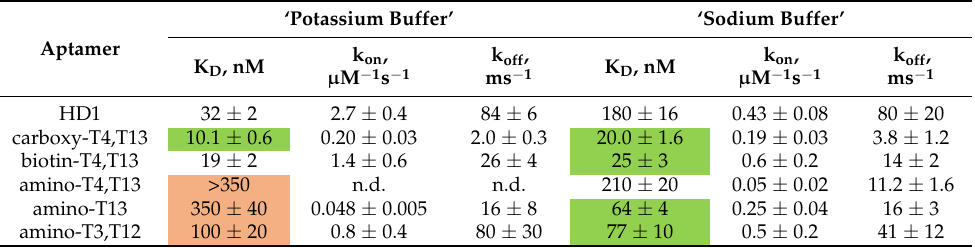
Table 3. The characteristics of the aptamer–thrombin complexes, namely, dissociation constants (K D ), kinetic association constants (k on ), and kinetic dissociation constants (k off ). The experiments were carried out in two buffer systems, with and without K + , that greatly affect the stability of the G-quadruplex structure. The colored cells refer to more than a 2-fold increase (green color) or decrease (orange color) in affinity. n.d.: not